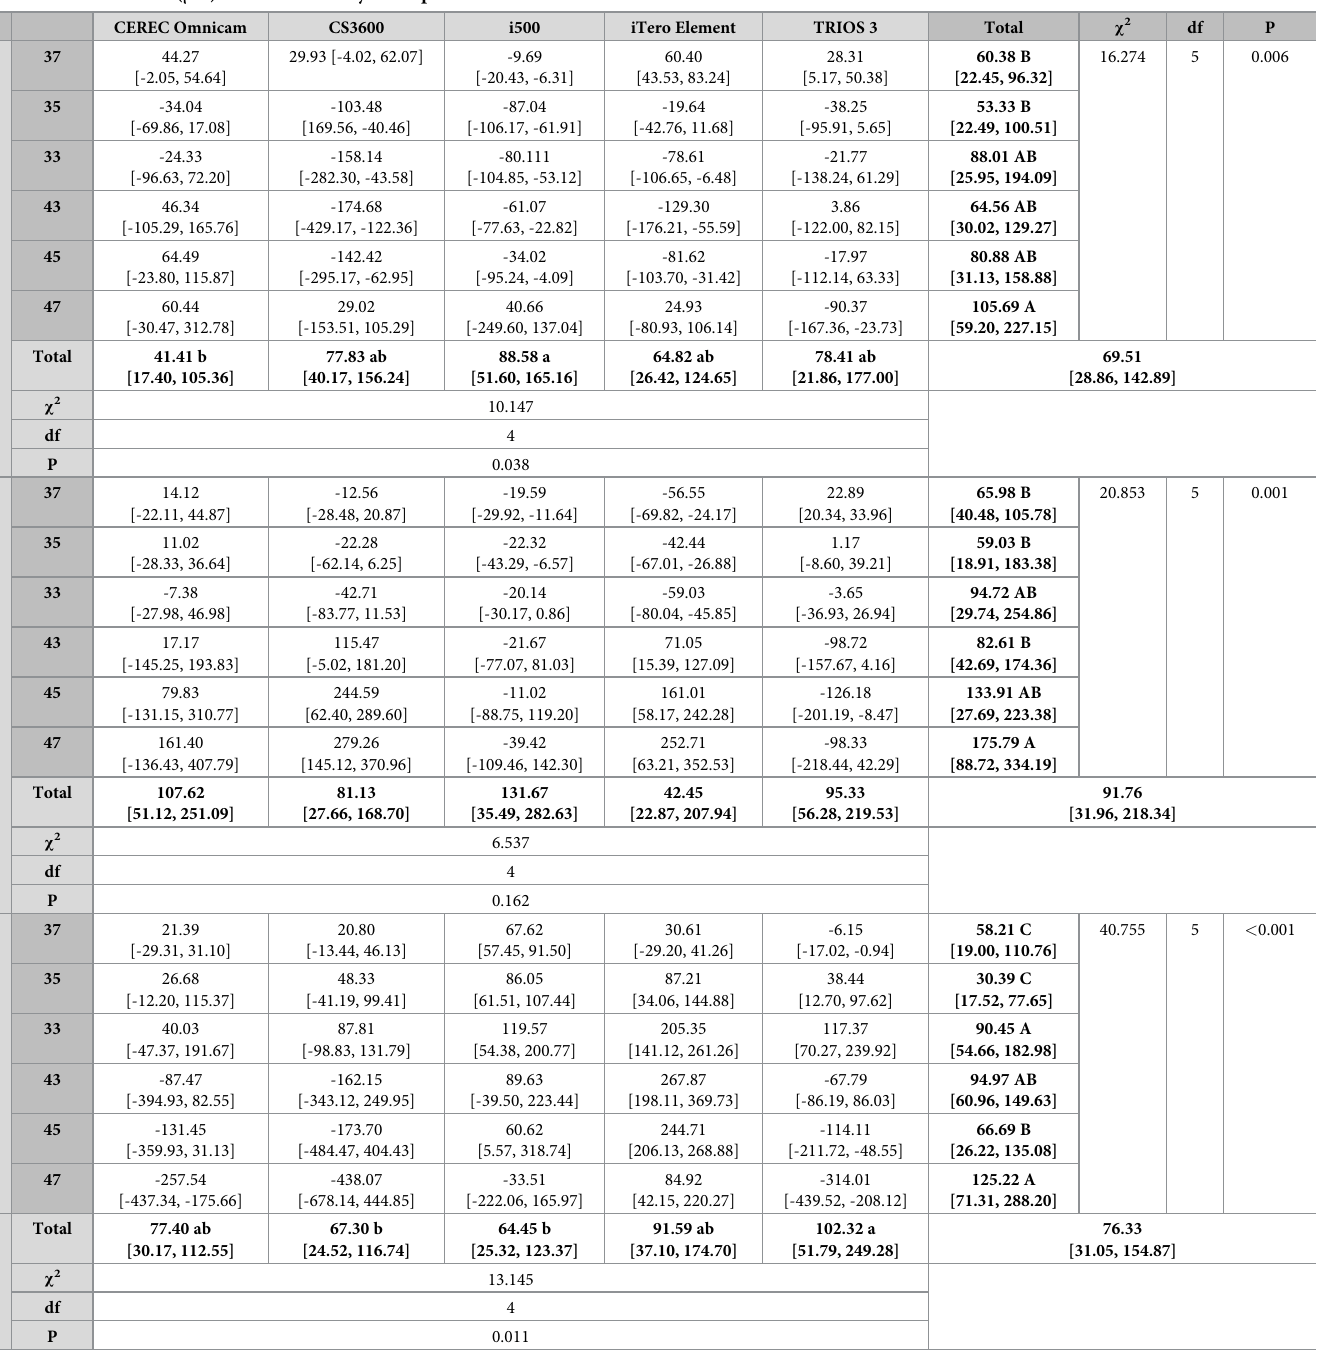
Table 2. Trueness values ( μ m) of IOSs at each cylinder position in XYZ axes. CEREC Omnicam CS3600 i500 iTero